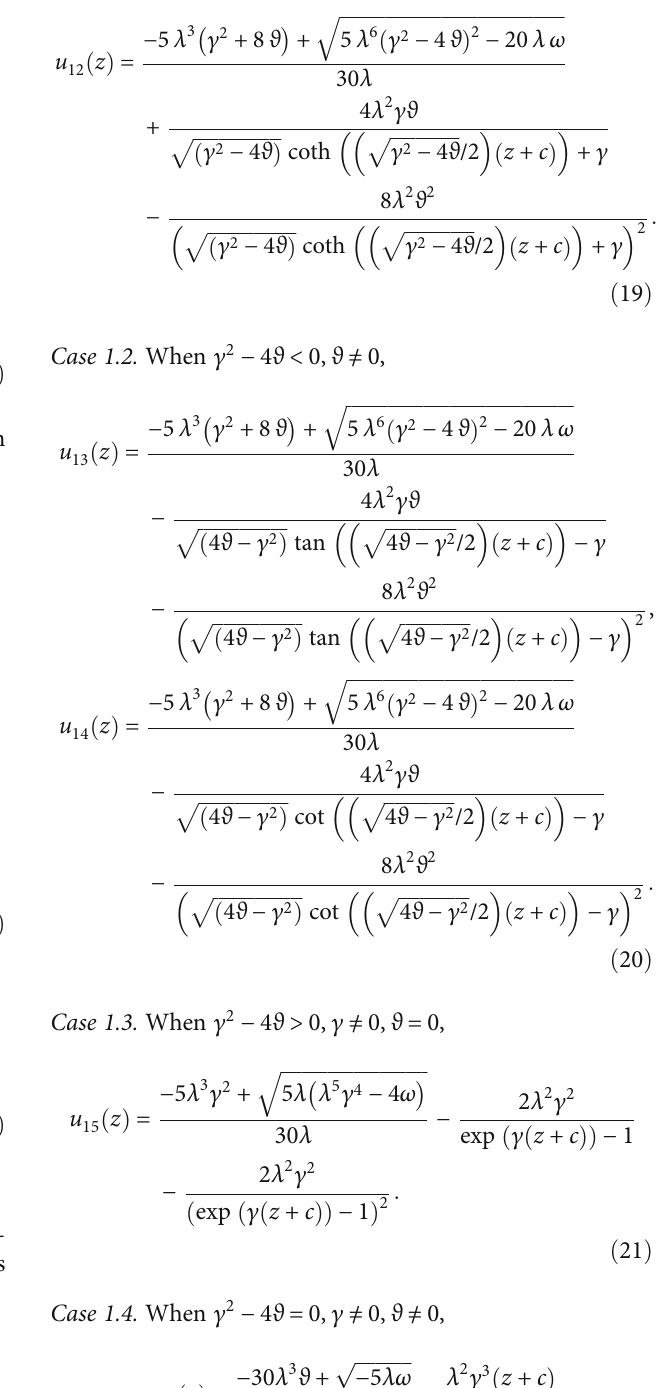
ffiffiffiffiffiffiffiffiffiffiffiffiffiffiffiffiffiffi ffiffiffiffiffiffiffiffiffiffiffiffiffiffi ffiffiffiffiffiffiffiffiffiffiffiffiffiffiffiffiffiffi p 4 ϑ − γ 2 ð Þ